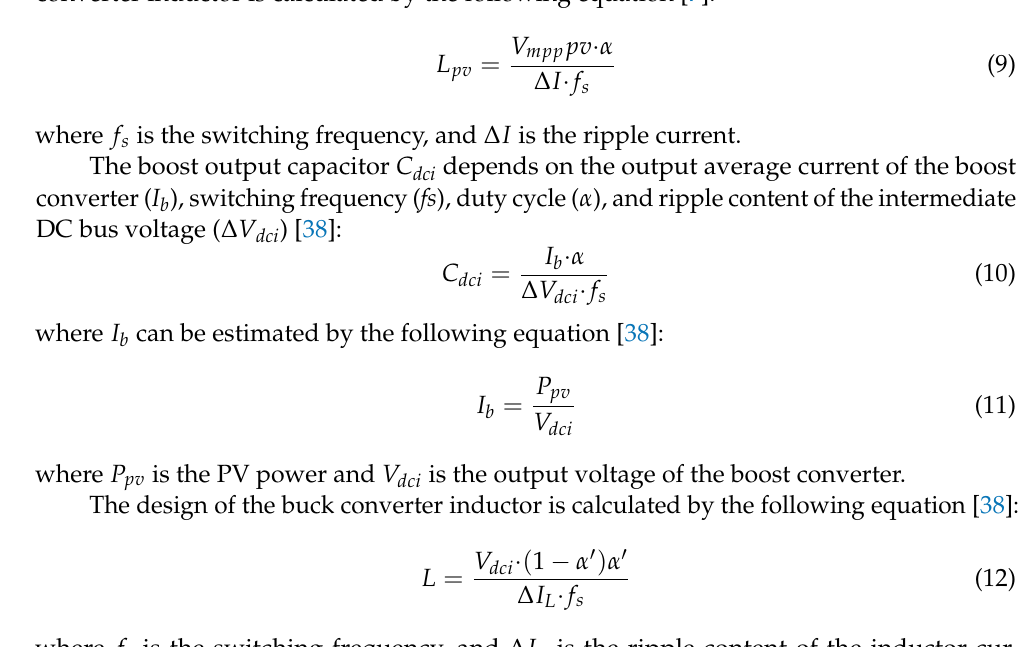
Table 2 resumes the parameters of the boost-buck